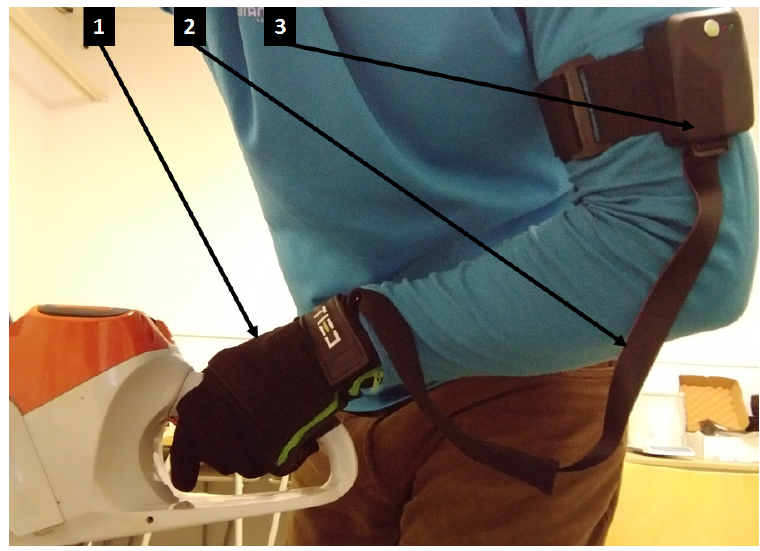
Figure 3. Feed force monitoring system: 1—glove with pressure sensors, 2—data cable, 3—data box/Bluetooth transmitter.